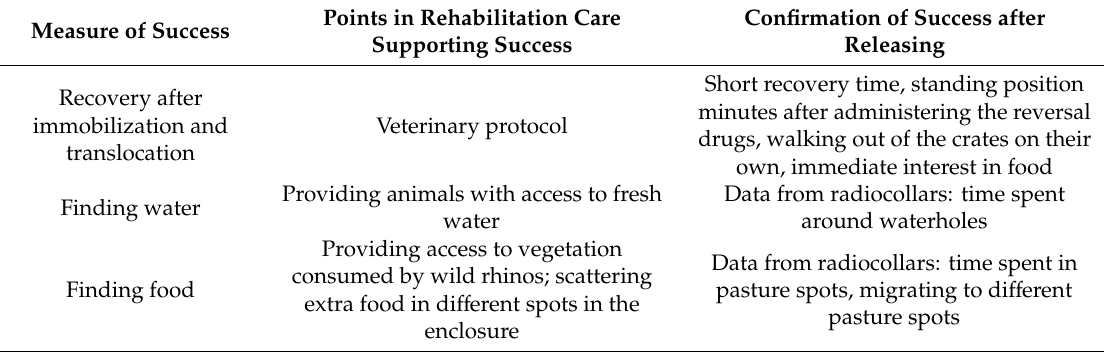
Table 3. Points of confirmation of successful